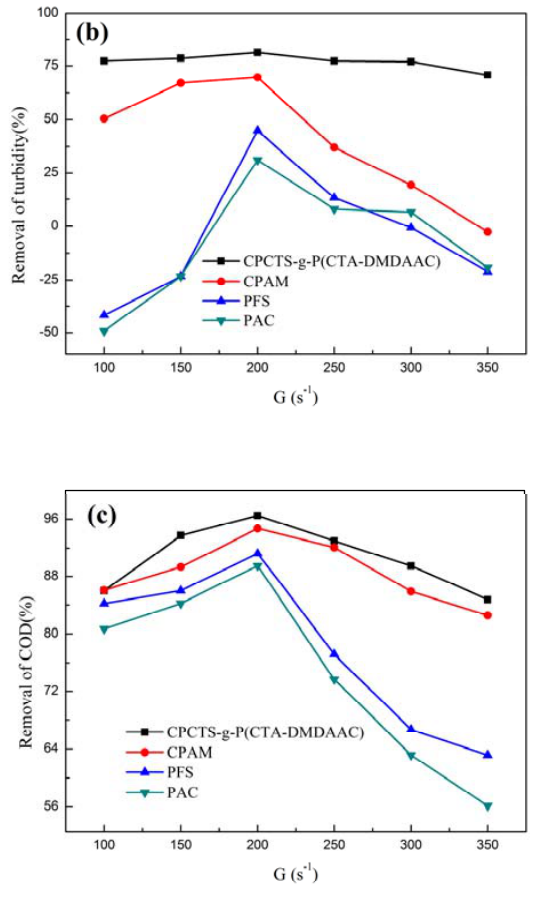
Figure 8. Effect of G value on flocculation properties: ( a ) Chl-a; ( b ) turbidity; ( c ) COD.